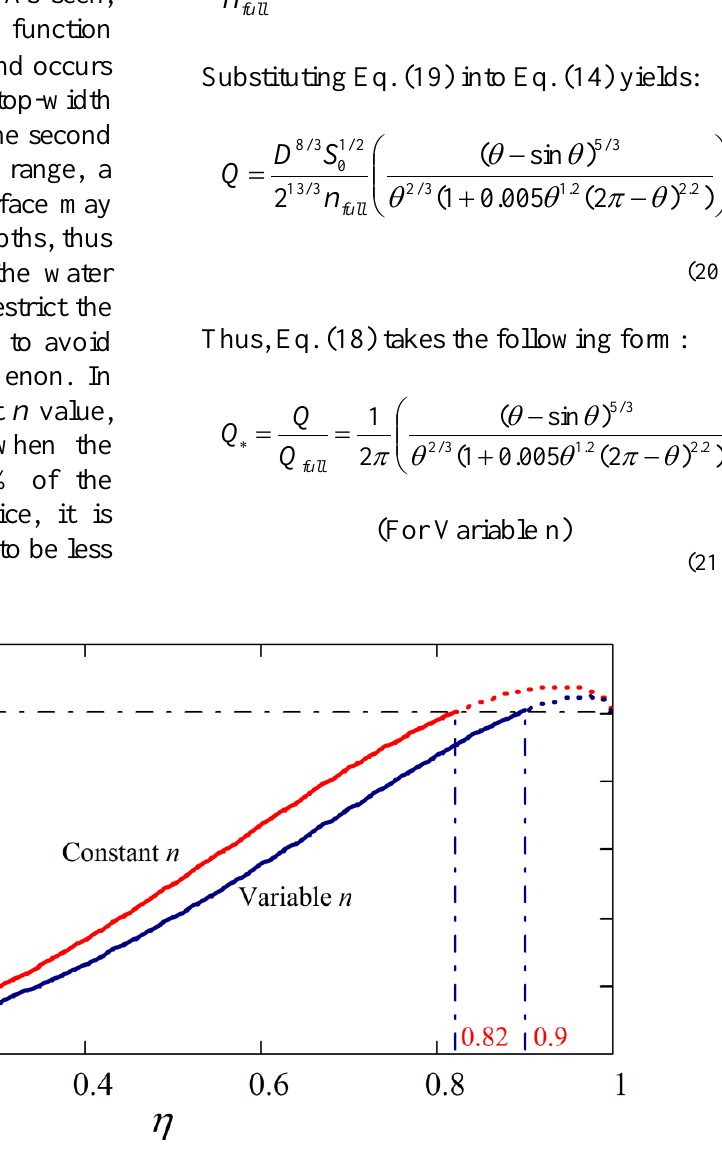
Fig. 2. Illustration of the double depth phenomenon in circular